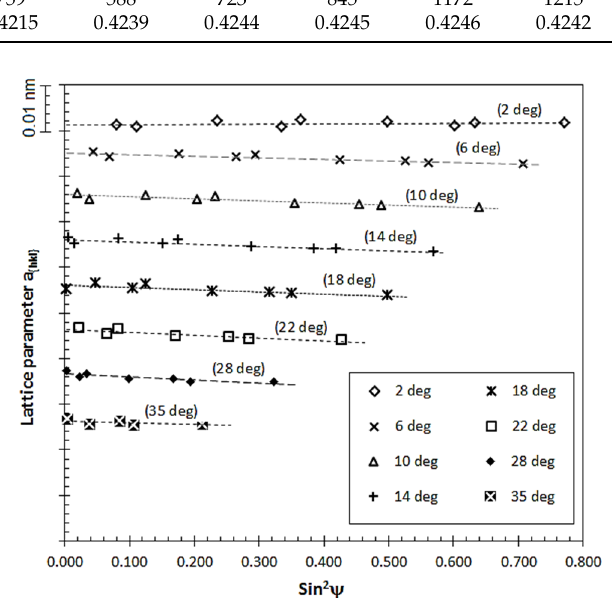
Figure 7. The a { hkl } vs. sin 2 ψ plots for various Ω angles calculated under the GIXRD mode.